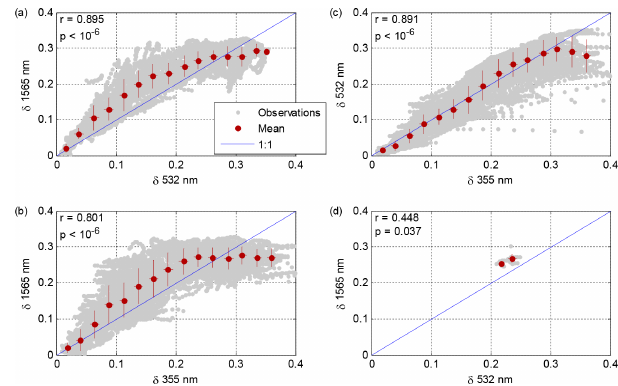
Figure 15. Comparison of particle linear depolarization ratio at dif- ferent wavelengths. Observations represent 30m vertical resolution and have been smoothed by a 300m running mean. To reduce scat- ter, a stricter uncertainty threshold is applied, and only data for σ δ < 0 . 01 (at the 1565nm wavelength) are included. The mean is calculated at intervals of 0.025 on the x axis, and error bars indi- cate standard deviation. (a) Depolarization ratio at 1565nm (Halo) vs. depolarization ratio at 532nm (PollyXT) at Limassol. (b) Depo- larization ratio at 1565nm vs. depolarization ratio at 355nm (Pol- lyXT) at Limassol. (c) Depolarization ratio at 532nm vs. depo- larization ratio at 355nm at Limassol. (d) Depolarization ratio at 1565nm vs. depolarization ratio at 532nm at